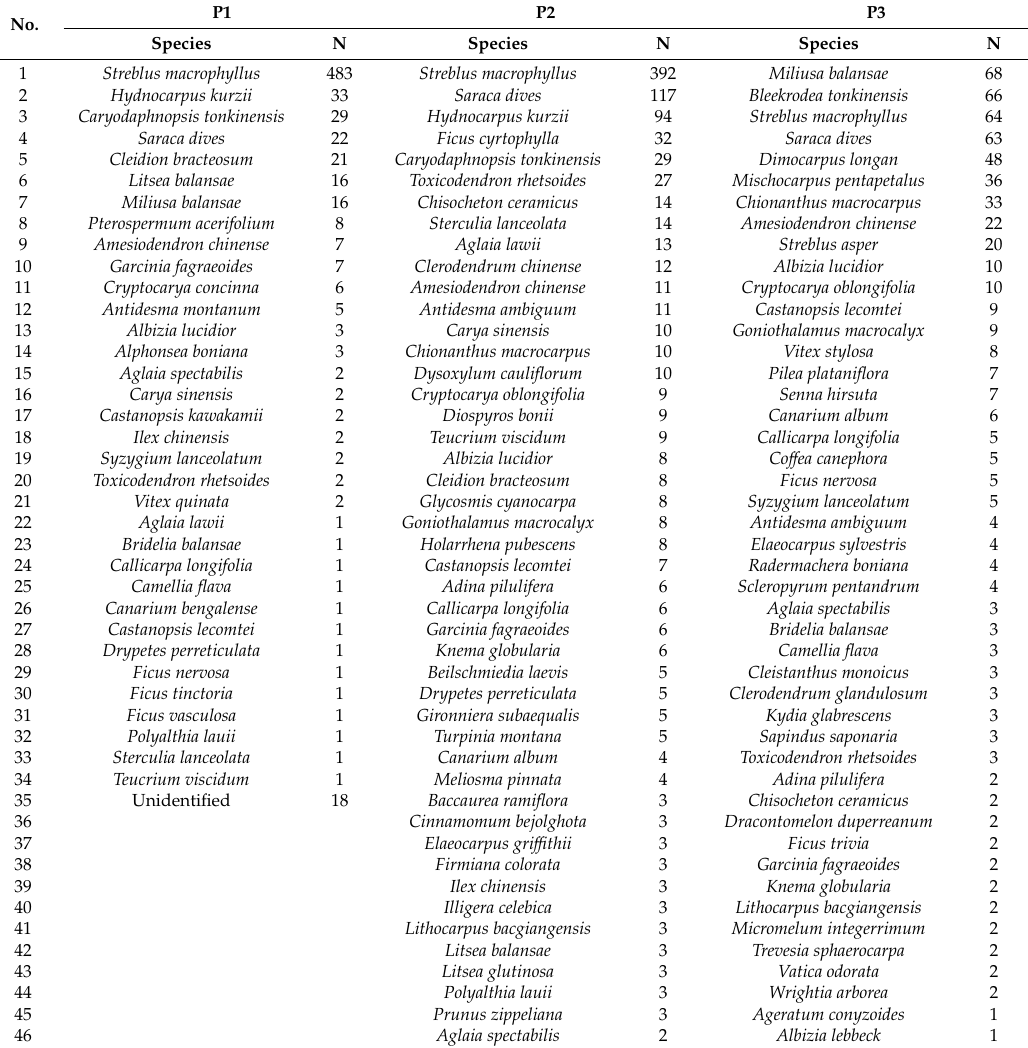
Table A1. Species list in three sample